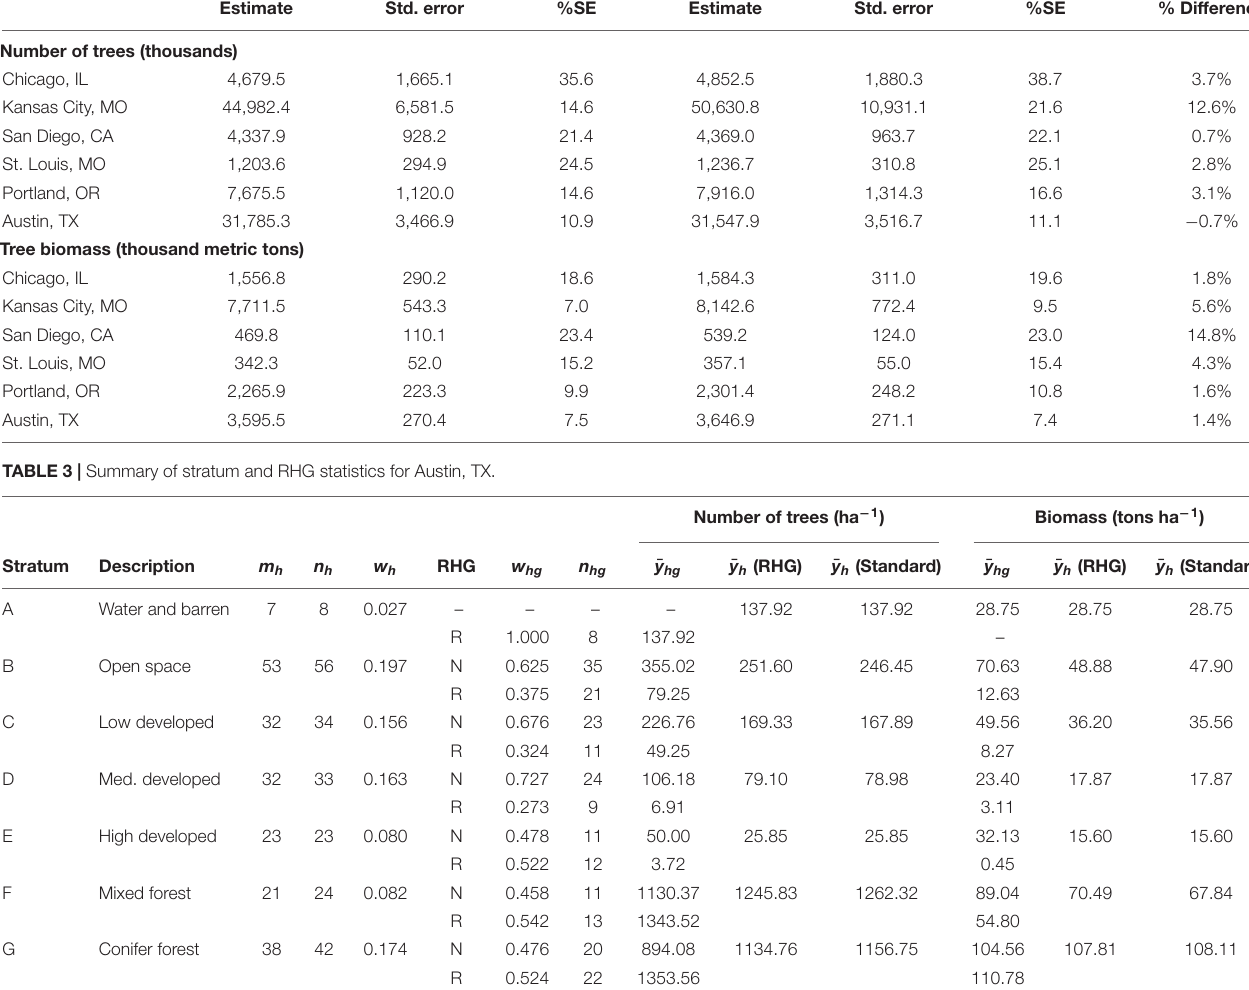
TABLE 2 | Comparison between standard and RHG estimation results for number of trees and total tree biomass in six cities in the United States. Standard estimation